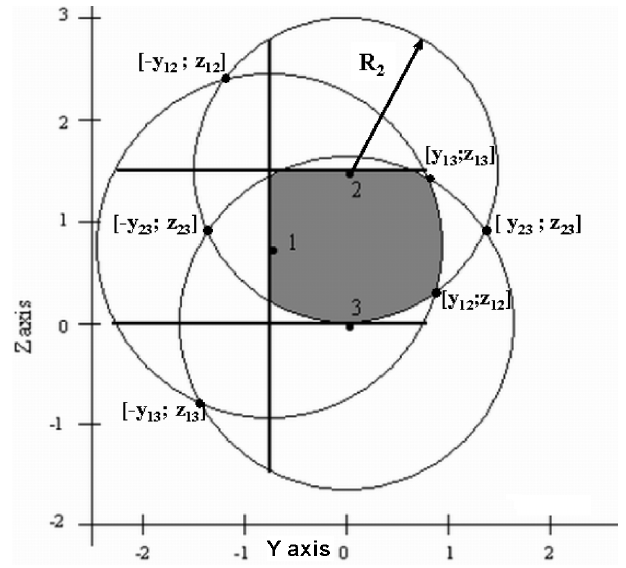
Figure 12: The cross-sectional workspace area of the Gantry-Tau in the YZ-plane.